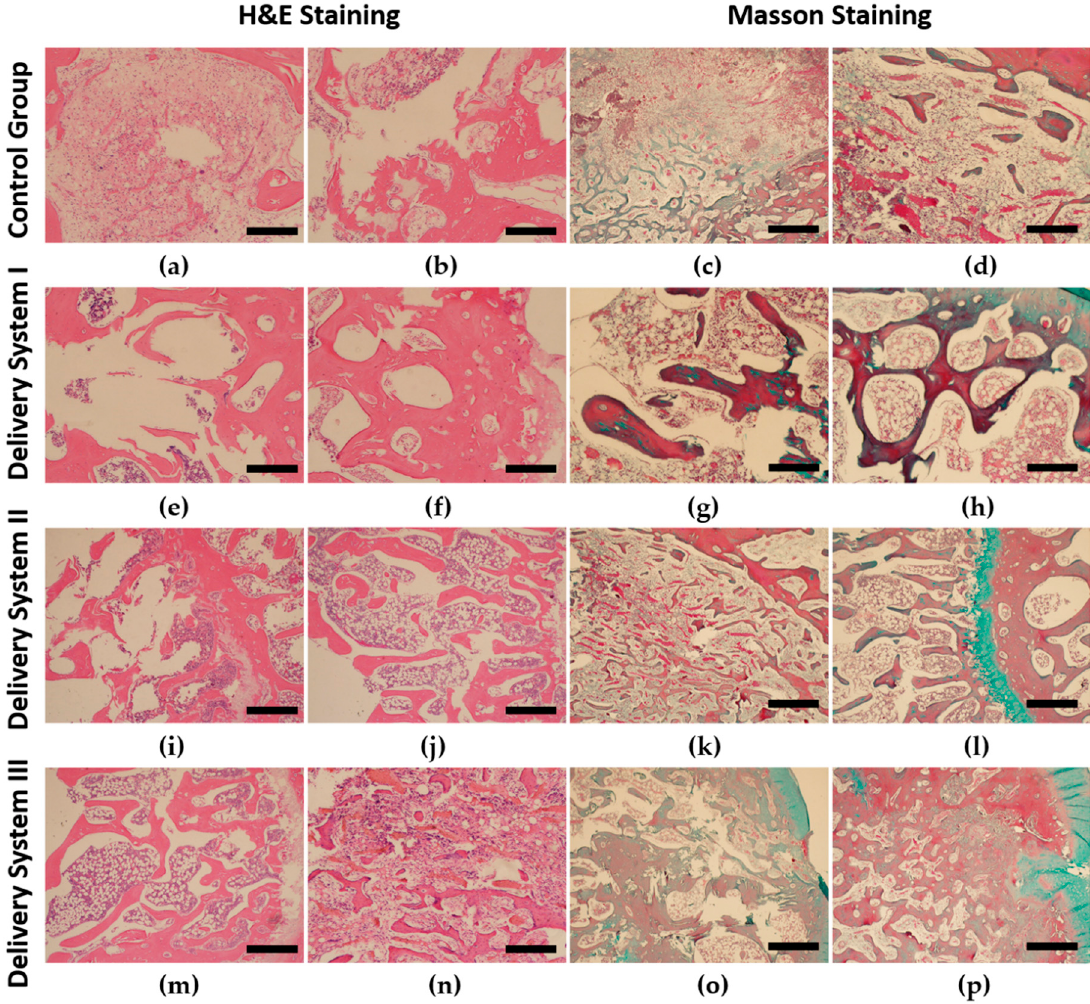
Figure 4. The representative optical images of H&E and Masson staining slices of cross sections at the necrosis site where the composite hydrogels were implanted at the 4th and 8th weeks. ( a , c ) Control groups without intervention at 4th weeks; ( b , d ) control groups without intervention at 8th weeks; ( e , g ) the necrosis site treated by using composite hydrogels with delivery system I at 4th week; ( f , h ) the necrosis site treated by using composite hydrogels with delivery system I at the 8th week; ( i , k ) the necrosis site treated by using composite hydrogels with delivery system II at the 4th week; ( j , l ) the necrosis site treated by using composite hydrogels with delivery system II at the 8th week; ( m , o ) the necrosis site treated by using composite hydrogels with delivery system III at the 4th week; ( n , p ) the necrosis site treated by using composite hydrogels with delivery system III at the 8th week. Scale bar: 100 μ m.